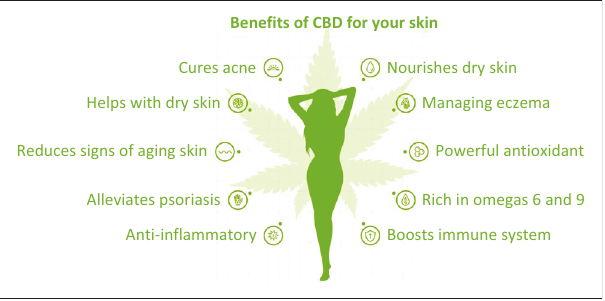
FIGURE 1: Benefits of cannabidiol for your skin.